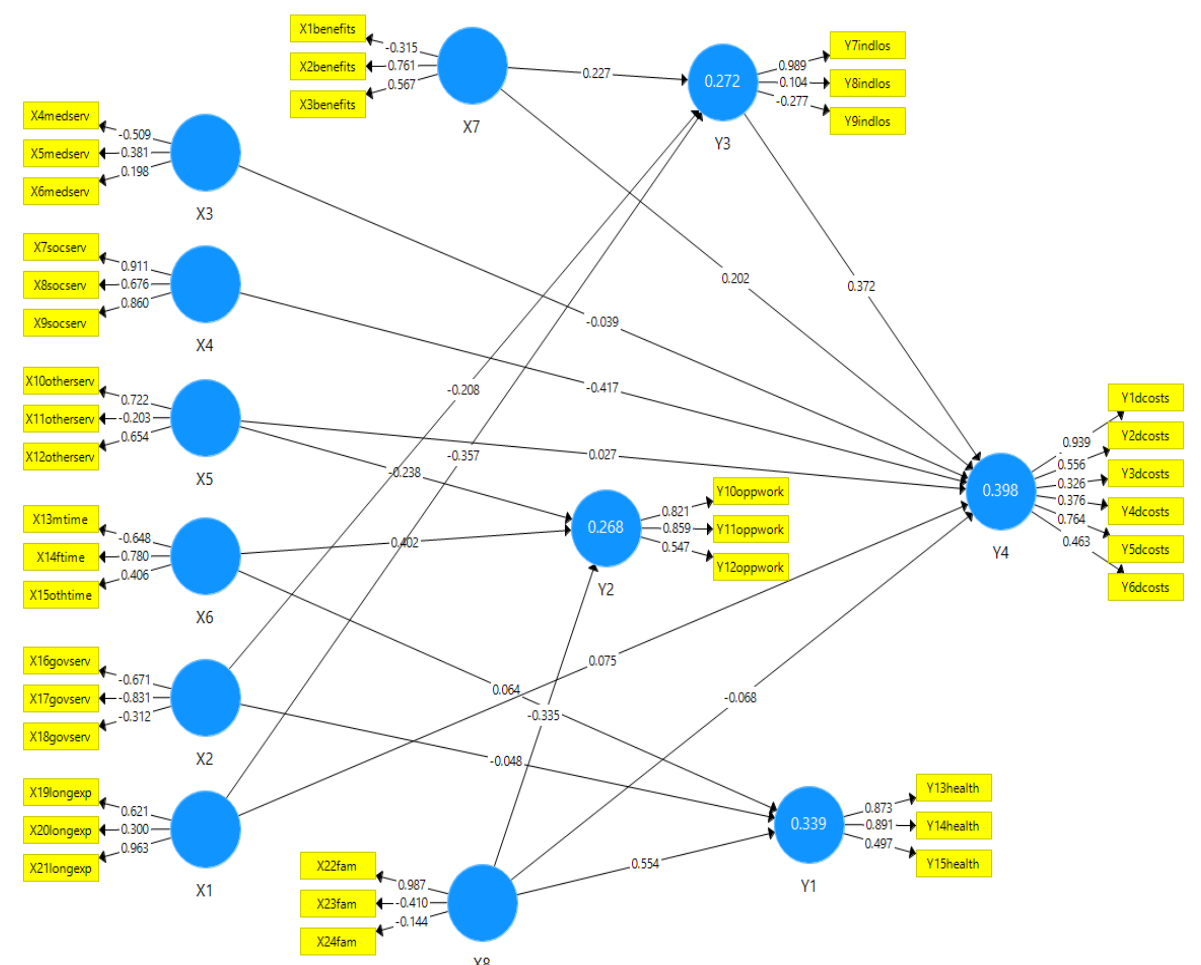
Figure 1. Structural model. Source: own elaboration based on SmartPLS program analysis.